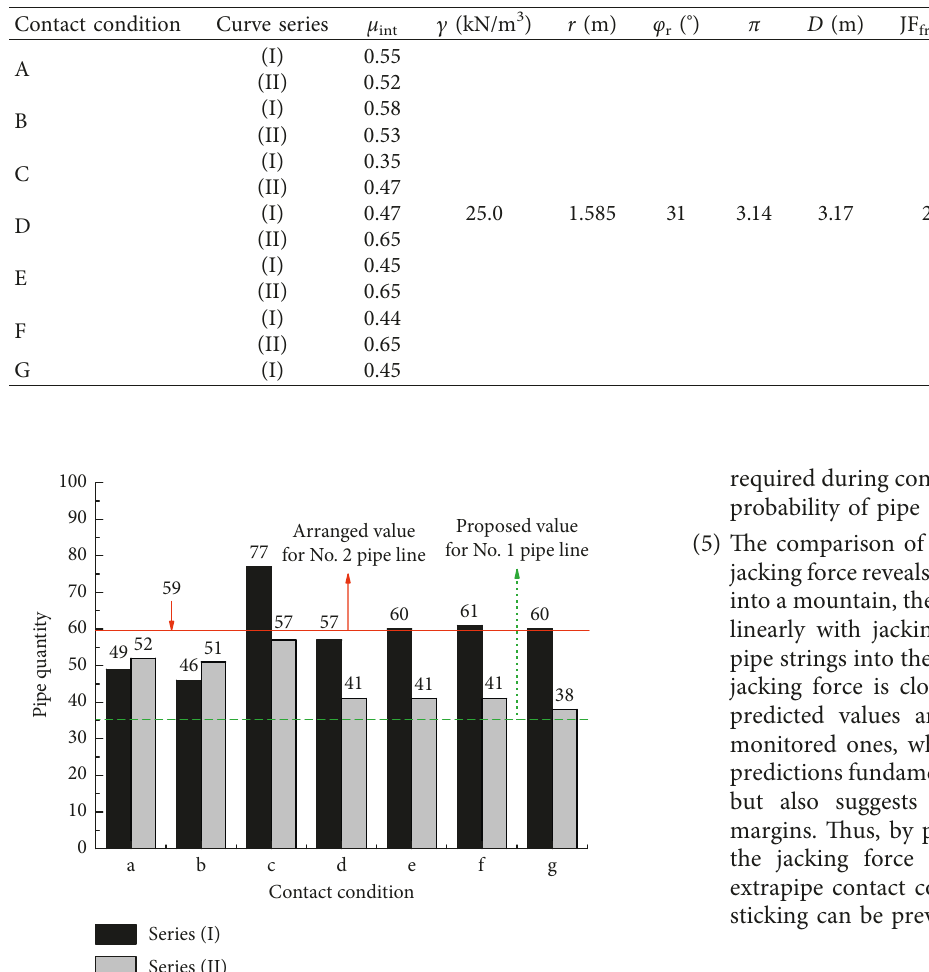
Figure 17: Cartogram of the maximum number of pipes driven by adjacent IJSs under different contact conditions.